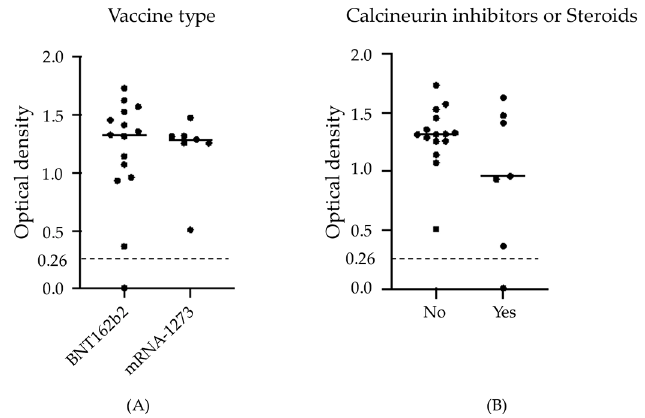
Figure 2. Comparison of antibody titers after the third vaccine in each group: ( A ) vaccine type, and ( B ) with or without calcineurin inhibitors or steroids. Antibody titers after the third vaccine did not significantly differ between vaccine types or with or without immunosuppressants. The broken line indicates the cut-off value (0.26) for seroconversion.